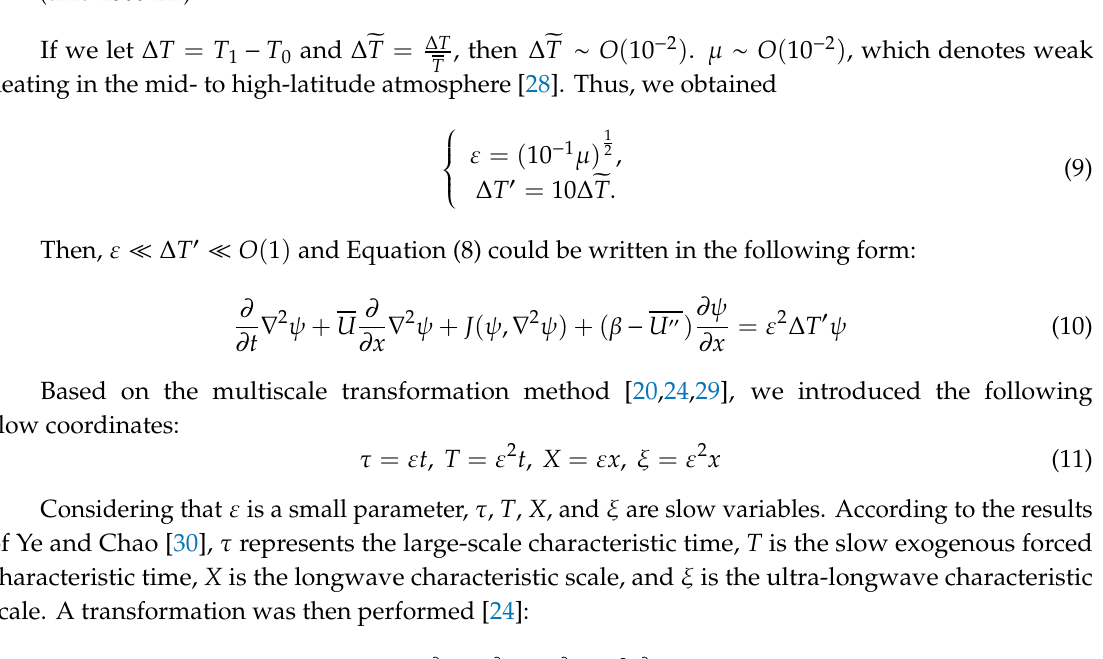
Figure 1. Thermal distribution due to K ∇ 2 ϕ ∗ = µψ ; solid (dotted) line represents the heat (cold) source (unit: 1500